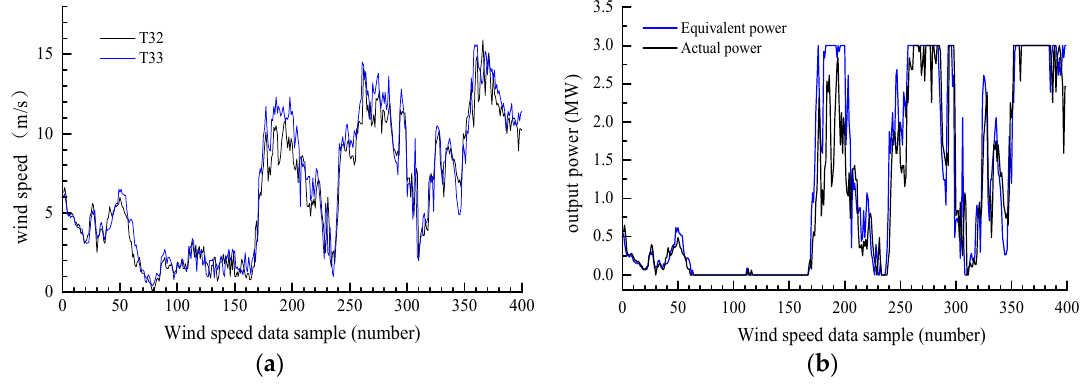
Figure 10. Comparison curve of equivalent power and actual power; ( a ) Actual wind speed curves; ( b ) Equivalent power curve and actual power curve.